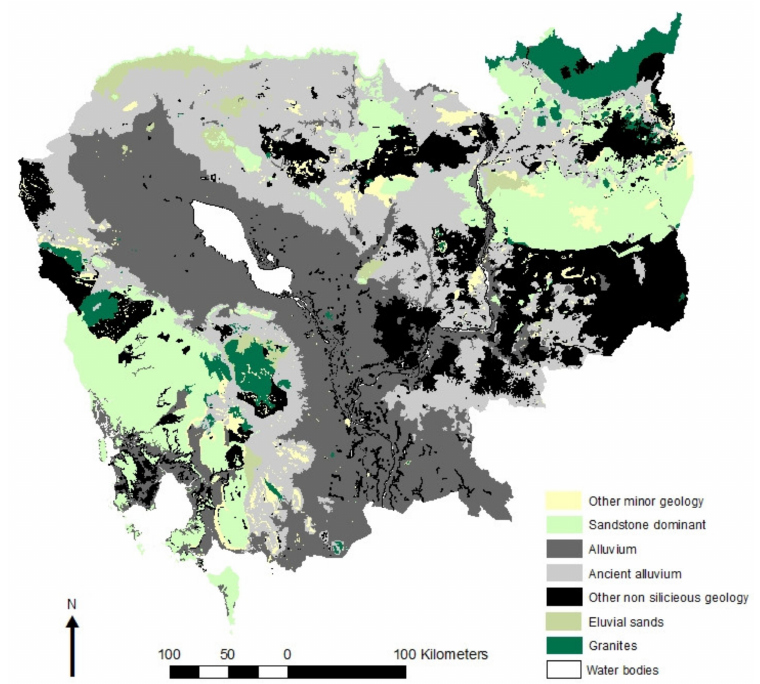
Figure 2. Generalized geology of Cambodia